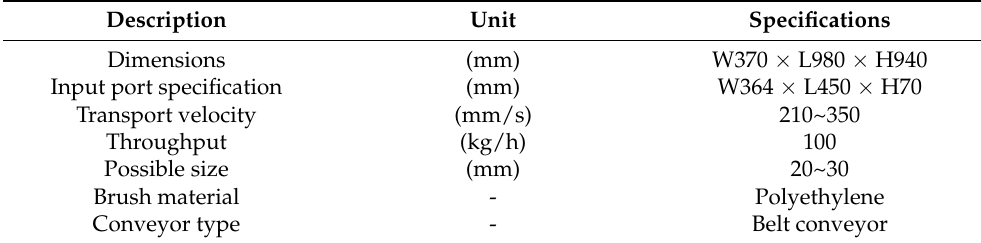
Table 1. Specifications of the conveyor-type calyx remover.